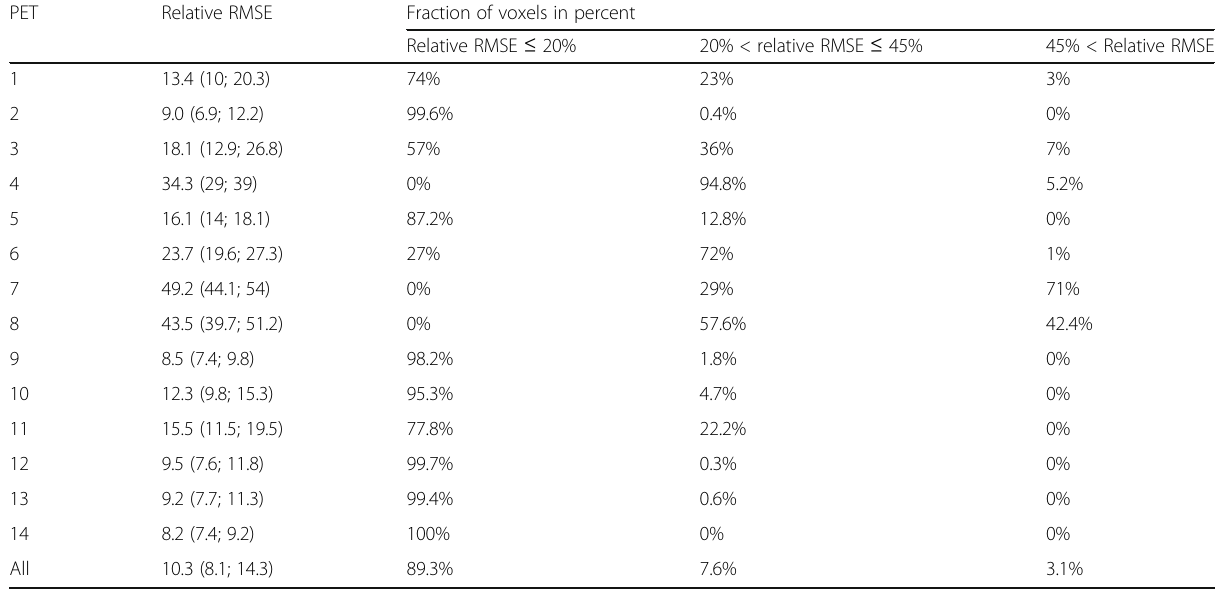
Relative RMSE data are expressed as median (IQR)